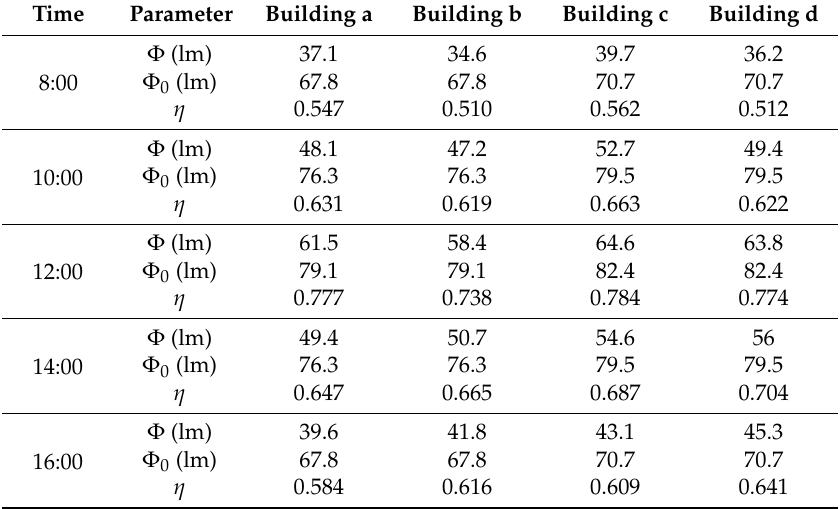
Table 5. Average luminous flux and efficiency of the SOGL system in the building group at different